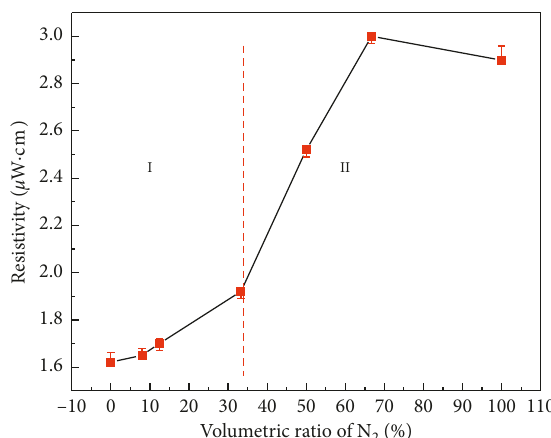
Figure 6: Resistivity of silver thin films as a function of the vol- umetric ratio of N 2